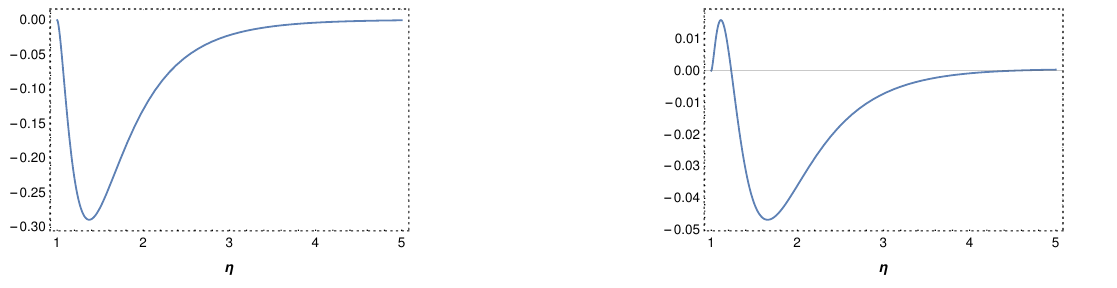
Figure 2. Behavior of the “effective” strong energy condition ( left ) and “effective” null energy ( right ) condition for ω = − 1.43 represented in the left-hand side of Equations (33) and (34), taking into account the effects of the non-minimal